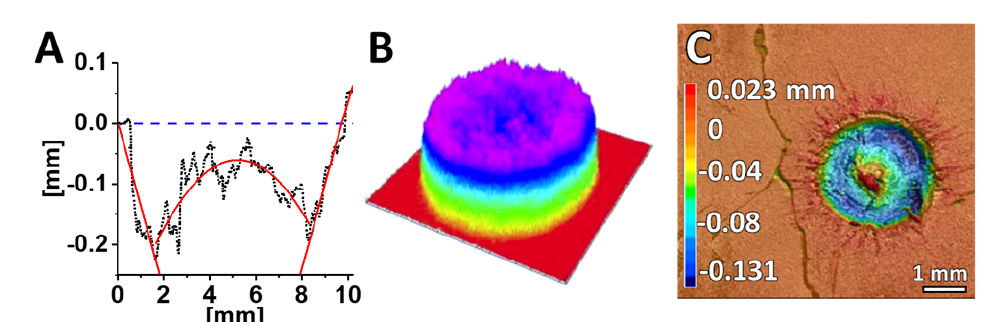
Figure 4. Profile of the PALS ablation crater on the chondritic meteorite NWA 8212 created by a single shot of about 500 J. The beam focal spot was approximately 10 mm in diameter ( panel A ). The intensity profile of the PALS laser beam ( panel B ) [77] and a hillock formation in the ablation spot center on an iron part of the Seymchan pallasite ( panel C ).